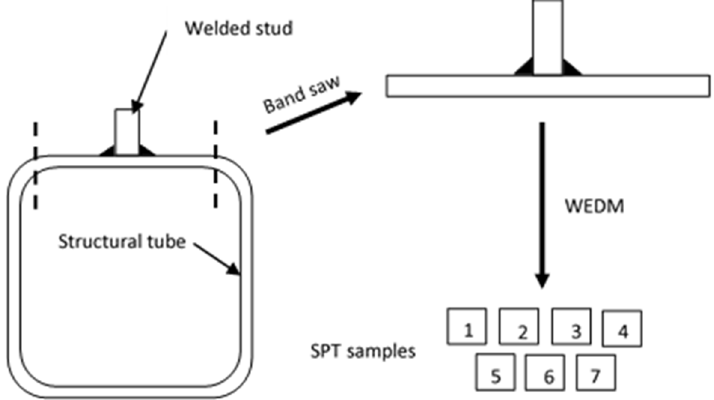
5 of 18 Figure 2. Distribution of temperatures along the tube surface: ( a ) 4 s after the arc welding, ( b ) 6 s after the arc welding, and ( c ) 24 s after the arc welding. In the graph, cooling rate of stud (P1), ceramic ferrule (P2), and tube (P3). 2.2. Procedure of Getting the Samples